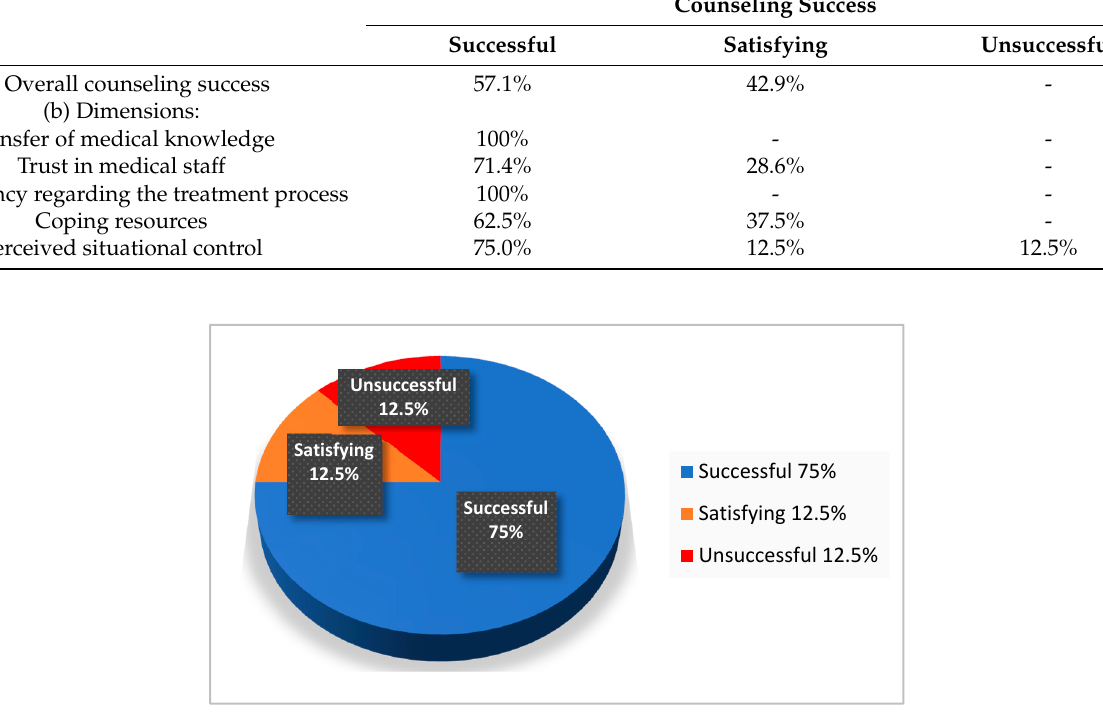
Figure 2. Overview of key results. Mean ranks displayed as column charts incl. p -values (Mann Whitney-U Test) for “Overall Counseling Success“, “Sorrow scales“ and selected modifiers for parental counseling success in the two sub- groups.